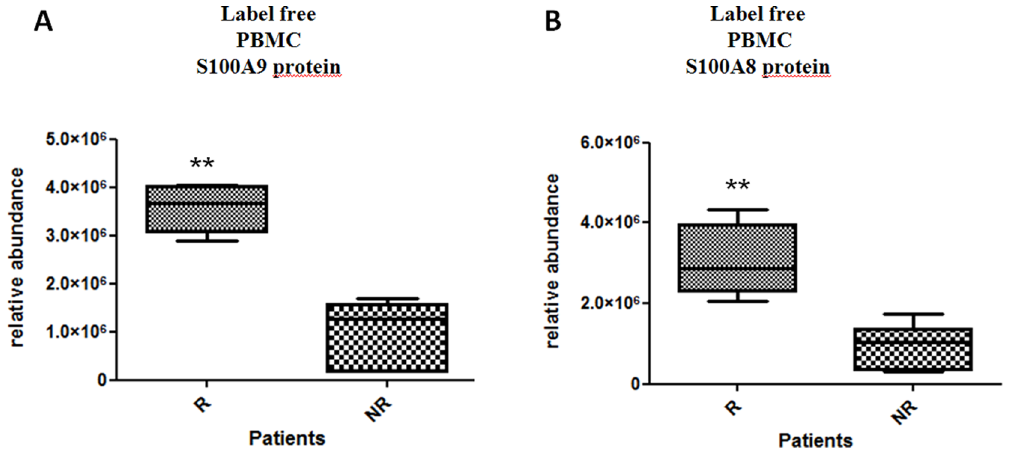
Fig. 2. Baseline expression of S100A8 and S100A9 in PBMCs from RA patients according to the response/non-response status to the ETA/MTX combination in the first population. Relative quantification by mass spectrometry of S100A9 protein (A) and S100A8 protein (B) at baseline in responders (n 5 3) versus non-responders (n 5 3) to MTX/etanercept (significant difference is noted by asterisk, p , 0.05; Mann-Whitney non-parametric test). Both S100A9 and S100A8 proteins accumulated in R patient (p-value 5 0.0022). The upper and lower bounds of each box indicate the 25 th and 75 th percentile respectively and heavy lines within the box represent the median. Whiskers are drawn to the min and max values.